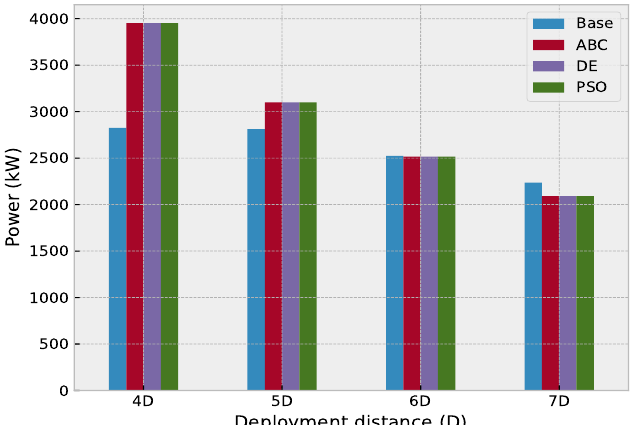
Figure 15. 7 D deployment distance at 8 m/s mean wind speed.